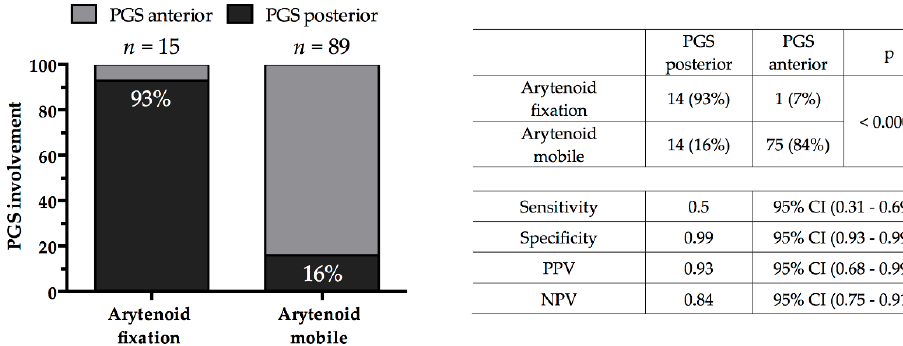
Figure 2. Association between clinical-endoscopic arytenoid mobility (normal vs. fixed) and radiological involvement of the PGS (anterior vs. posterior). p value was estimated by Fisher’s exact test. Legend: PGS, paraglottic space; PPV, positive predictive value; NPV, negative predictive value; CI, confidence interval.